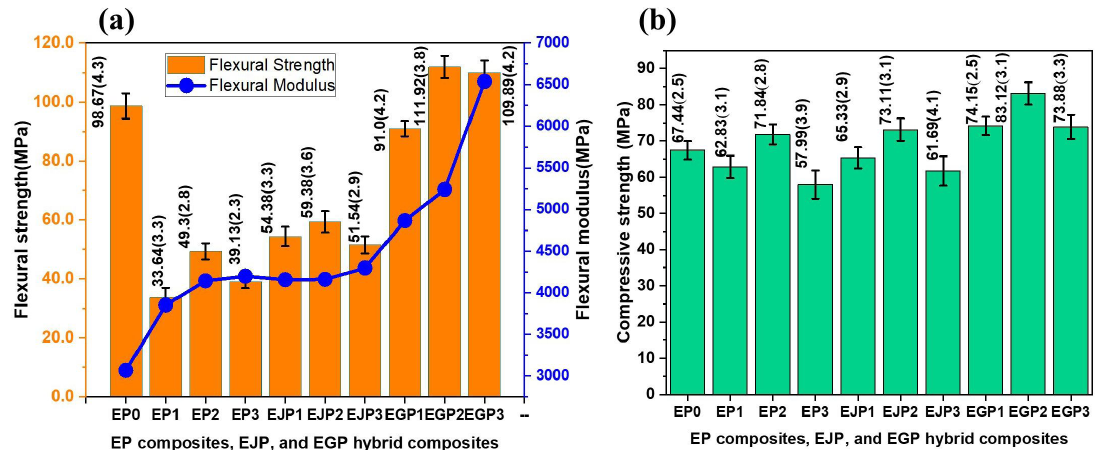
Figure 3. Mechanical characteristics of Epoxy, EP composites, and their hybrid composites: (a) Flexural characteristics, (b) Compressive